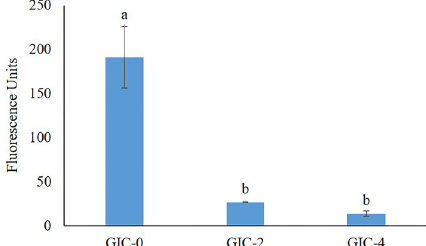
Figure 1. Growth of S. mutans in dynamic bio fi lms on glass ionomer cement (GIC) modi fi ed with thymol at different concen- trations: 0, 2, and 4%. Data are reported as mean ± SD. Different letters indicate signi fi cant differences between groups (P o 0.001, ANOVA and Tukey ’ s test).